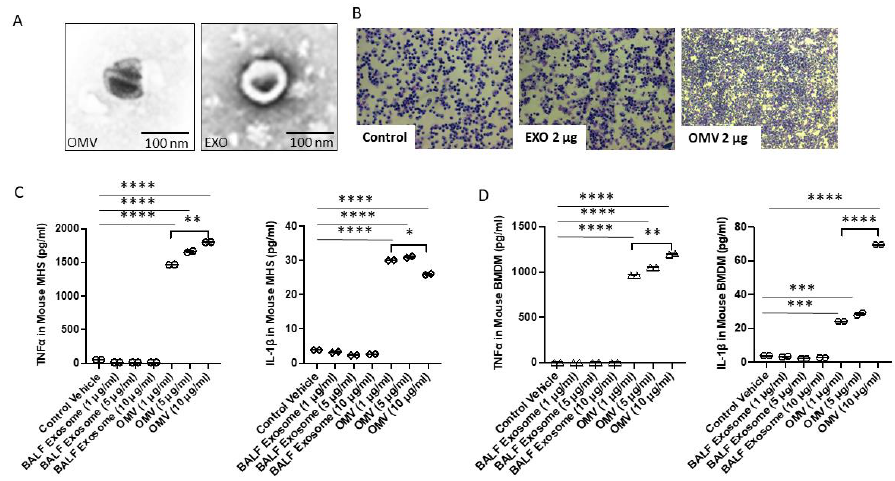
Figure 1. Effects of OMVs on MHS cells. Effects of OMVs on MHS cells. ( A ) TEM images of OMV and EXOs. Size similarity between OMV and EXO is shown. ( B ) Representative images of BALF cells collected from PBS, EXO-treated, and OMV-treated mice. 60 µ L PBS, 2 µ g of EXO or OMV with 60 µ L PBS were instilled intra-tracheally (i.t.) into WT mice. ( C , D ) TNF- α and IL-1 β levels in cells treated with control (elution buffer), exosomes (control), and OMVs in MHS cells ( C ) or BMDM ( D ). 24 h after stimulation, the above two cytokines were determined using ELISA ( n = 2). Results were expressed as mean ± SD. Statistical Analysis was performed non-parametrically using the One-way Analysis of variance (ANOVA) with Tukey’s multiple comparison tests to determine significant differences between the experimental groups. * p < 0.05, ** p < 0.01, *** p < 0.005, and **** p < 0.001 set as Statistical significance.